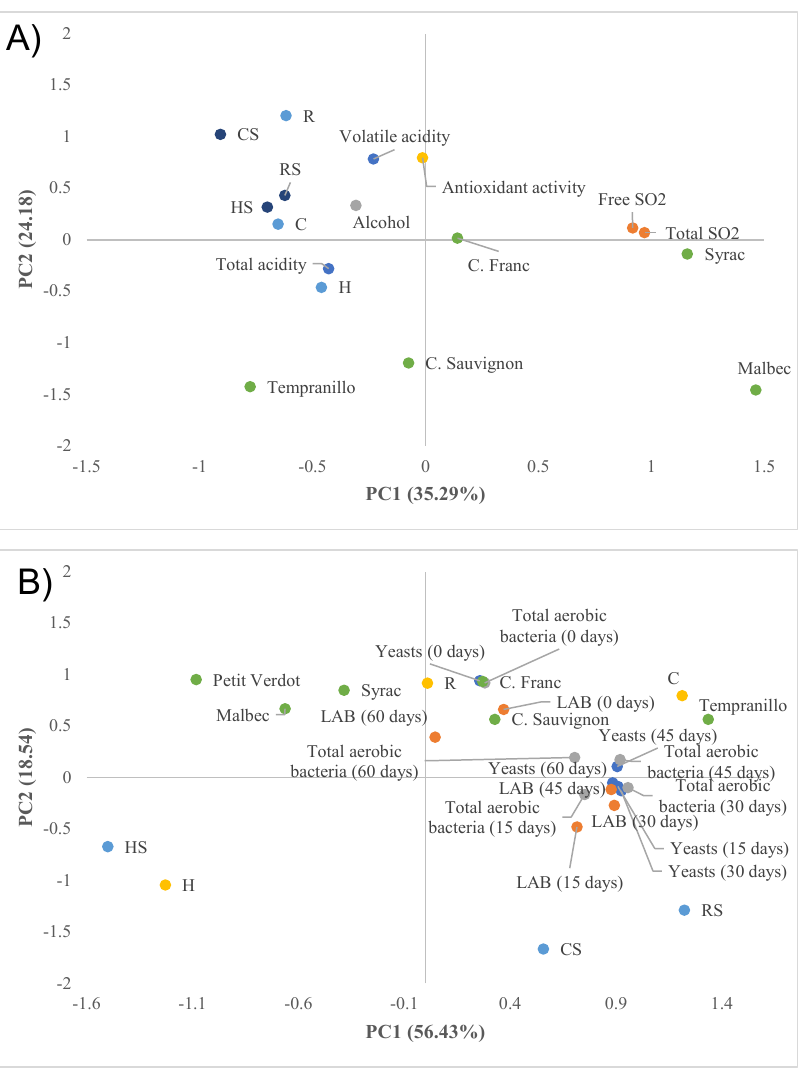
Figure 1. Representation of the physical–chemical variables in the samples analyzed after 60 days of storage ( A ) and microbiological analysis ( B ) in the samples analyzed during 60 days of storage in the plane defined by principal component 1 and principal component 2 of the principal component analysis. (C: control batch, CS: control batch with sulfur dioxide; R: batch of scratch, RS: batch of scratch plus sulfur dioxide, H: batch of skin and HS: batch of skin plus sulfur dioxide).